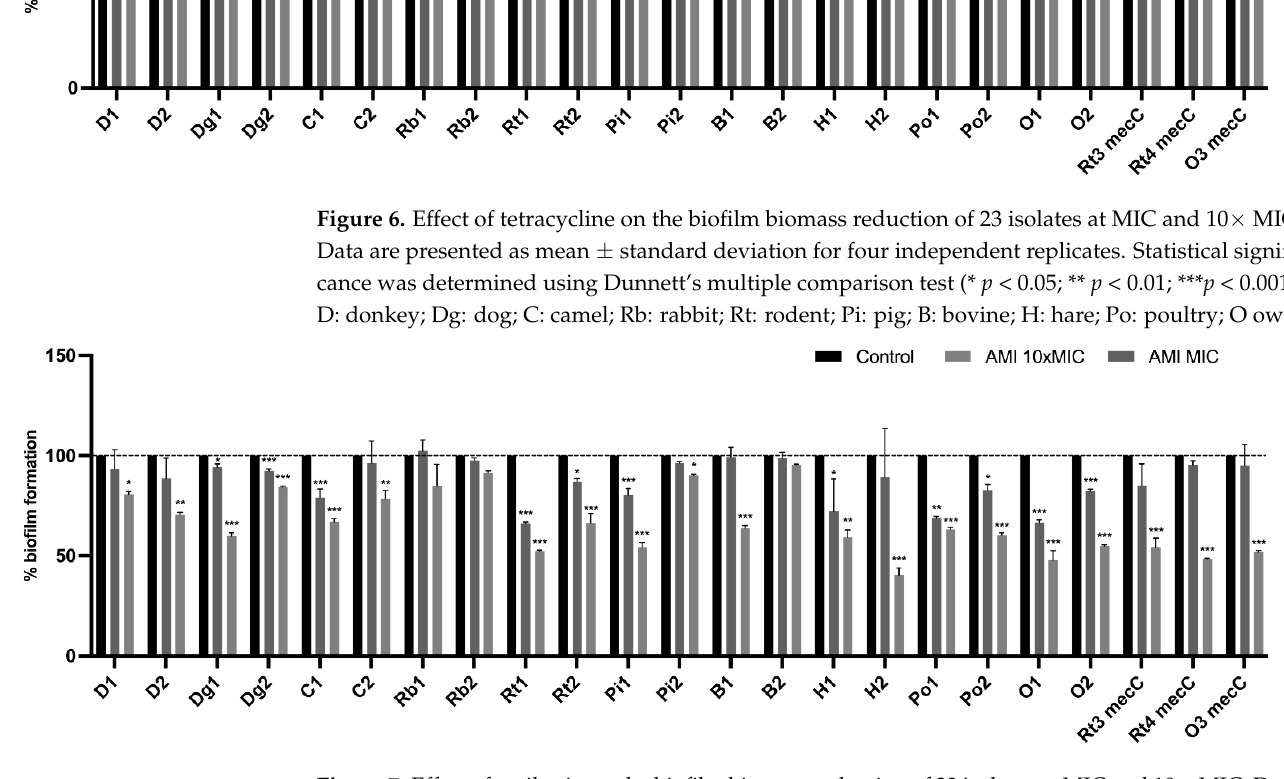
Figure 7. Effect of amikacin on the biofilm biomass reduction of 23 isolates at MIC and 10× MIC. Data are presented as mean ± standard deviation for four independent replicates. Statistical significance was determined using Dunnett’s multiple comparison test (* p < 0.05; ** p < 0.01; *** p < 0.001). D: donkey; Dg: dog; C: camel; Rb: rabbit; Rt: rodent; Pi: pig; B: bovine; H: hare; Po: poultry; O owl.